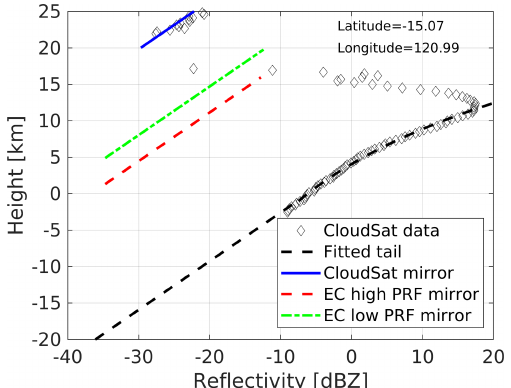
Figure 6. Example of folding of MS tails for the profile correspond- ing to the black line shown in Fig. 5. The CloudSat reflectivity pro- file (diamonds) which is sampled only down to − 2 . 5km is extrap- olated down to − 20km (dashed black line) and then folded back according to the CloudSat unambiguous range (blue line) and the two EarthCARE high- and low-PRF modes (red and green lines,